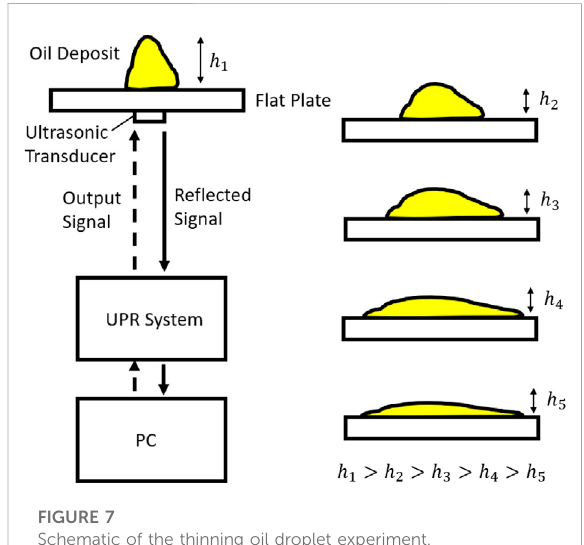
FIGURE 7 Schematic of the thinning oil droplet